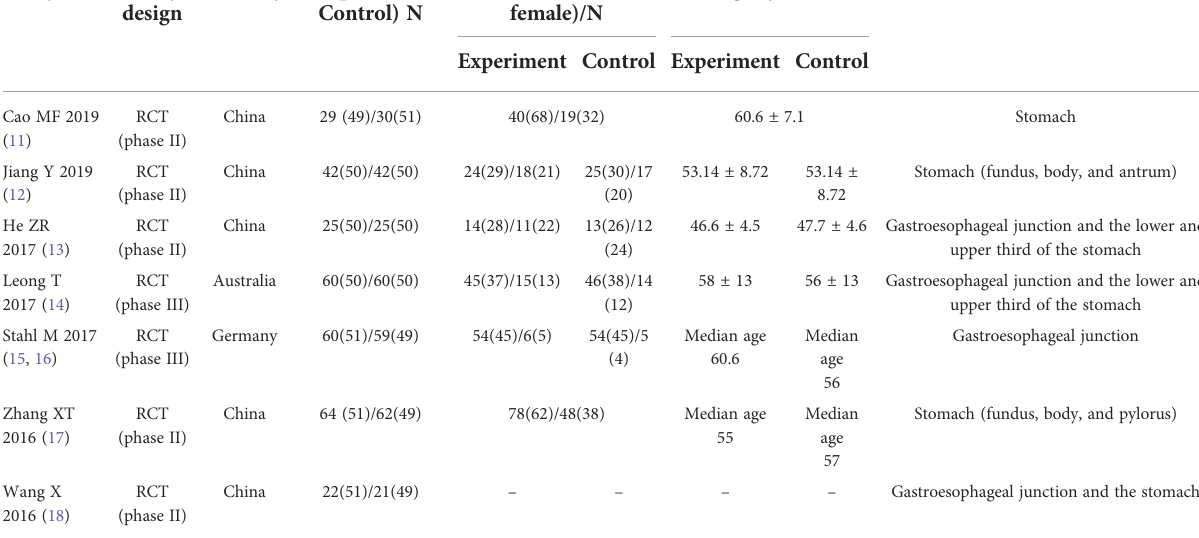
TABLE 1 Characteristics of studies